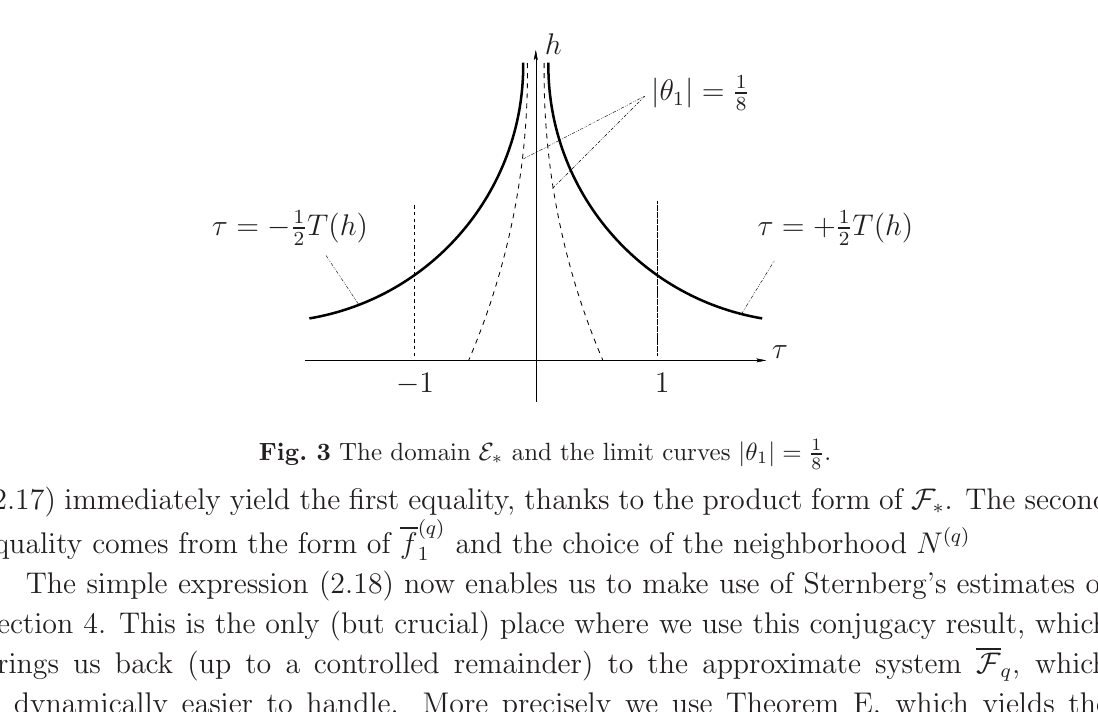
and the limit curves E ∗